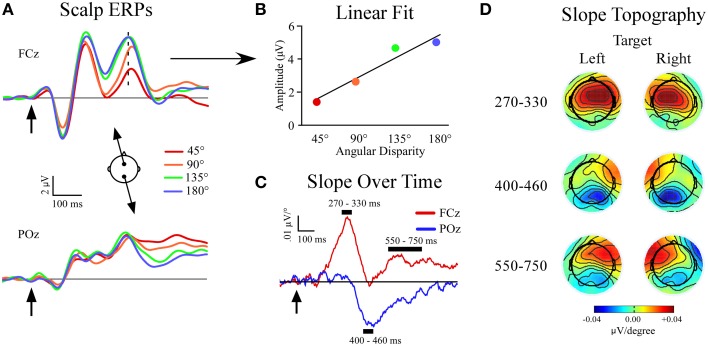
Slope of event-related potentials (ERPs) across non-target locations. (A) Event-related potentials to non-targets recorded at midline sites FCz and POz. Separate non-target ERPs are plotted by their angular disparity from the target location. (B) Demonstration of the least-squares linear fit procedure for t = 320 ms at FCz (indicated by dotted line in ERP). (C) Slope values plotted for each time-point at FCz and POz. (D) Topography of slope values across all channels within specified time windows and plotted separately for left (−90°) and right (+90°) target conditions. Arrows indicate stimulus onset.